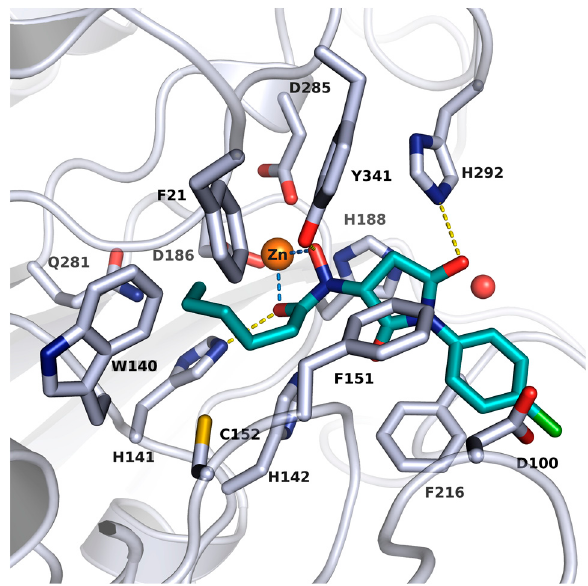
Figure 1. Docking pose of J1036 in smHDAC8 (PDB ID: 4BZ8). Protein backbone is shown as a ribbon and side chains of key amino acid residues in the active site are shown as white sticks. The catalytic zinc ion and water molecule are shown as an orange and red sphere, respectively. Coordination of the zinc ion by J1036 is represented with light blue lines while the hydrogen bond interaction between the docked hit and the protein is shown as a yellow line.